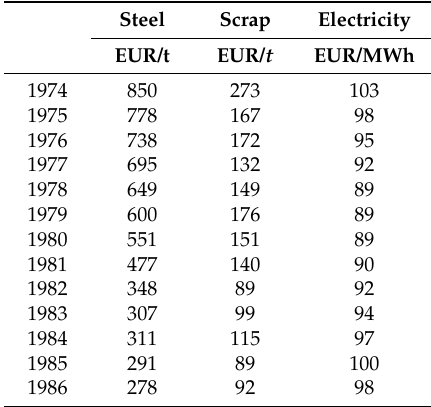
Table 1. Constant prices (in 2005 Euros) of steel, scrap and electricity used in f ( t ) of Equations (3) and (4).